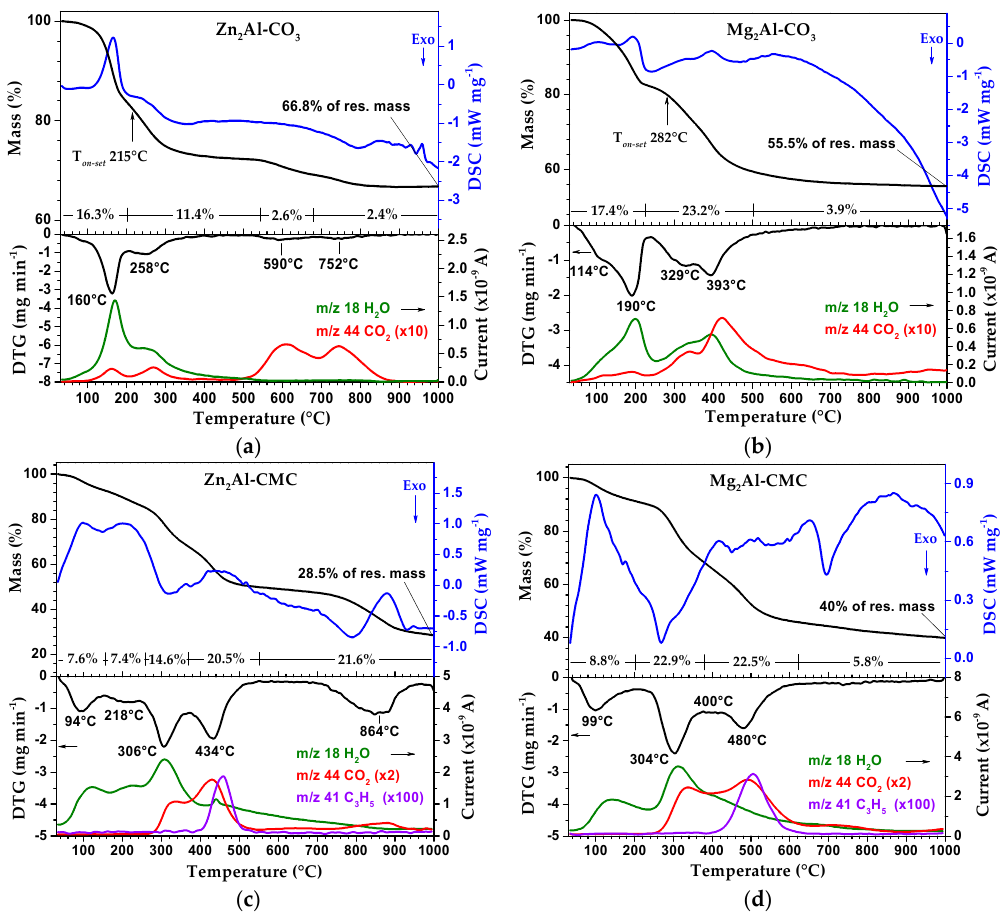
Figure 5. TG-DSC and DTG-MS curves of Zn 2 Al-CO 3 ( a ), Mg 2 Al-CO 3 ( b ), Zn 2 Al-CMC ( c ) and Mg 2 Al-CMC ( d ) samples under N 2 atmosphere.